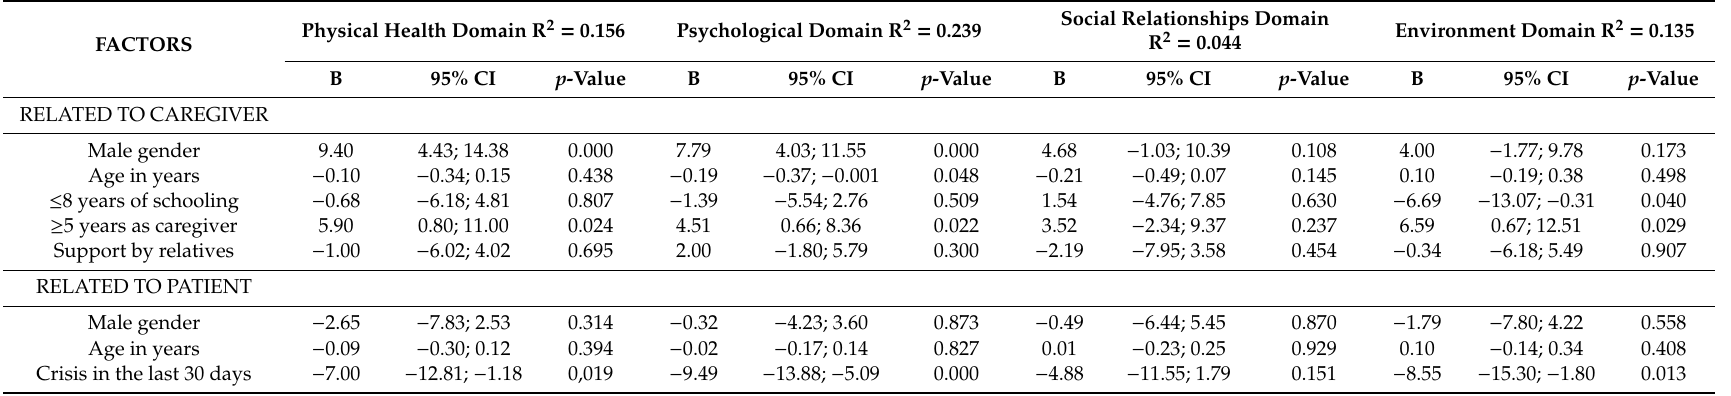
Table 3. Factors associated with scores of WHOQOL-BREF a domains of married family caregivers of patients with mental disorders, multiple linear regression.